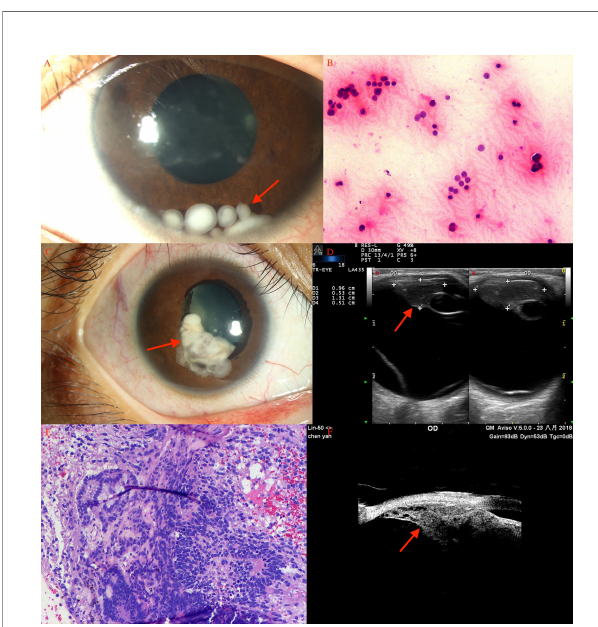
FIGURE 1 | Ciliary body medulloepithelioma of a 5-year-old boy. (A) The pompom-like pseudohypopyon (arrow) in the anterior chamber (original magni fi cations × 16). (left eye) (B) The anterior-chamber fi ne-needle aspiration biopsy showed small, round blue tumor cells, with small bland nuclei and relatively abundant eosinophilic cytoplasm, arranged in nest bulk (hematoxylin-eosin [HE], original magni fi cations×200). (C) Medulloepithelioma